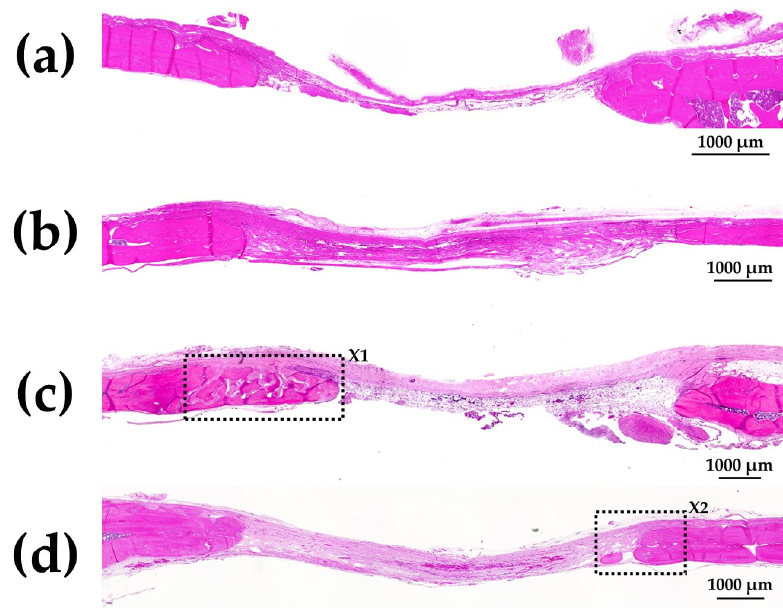
Figure 11. HE-stained histological images of rat cranial bone defects with and without the three granules: ( a ) defect only, ( b ) Col control + AG + b-FGF, ( c ) AI 20 min 5Cy Col/Hap + AG + b-FGF, and ( d ) AI 60 min 5Cy Col/Hap + AG + b-FGF. (4 × magnification).